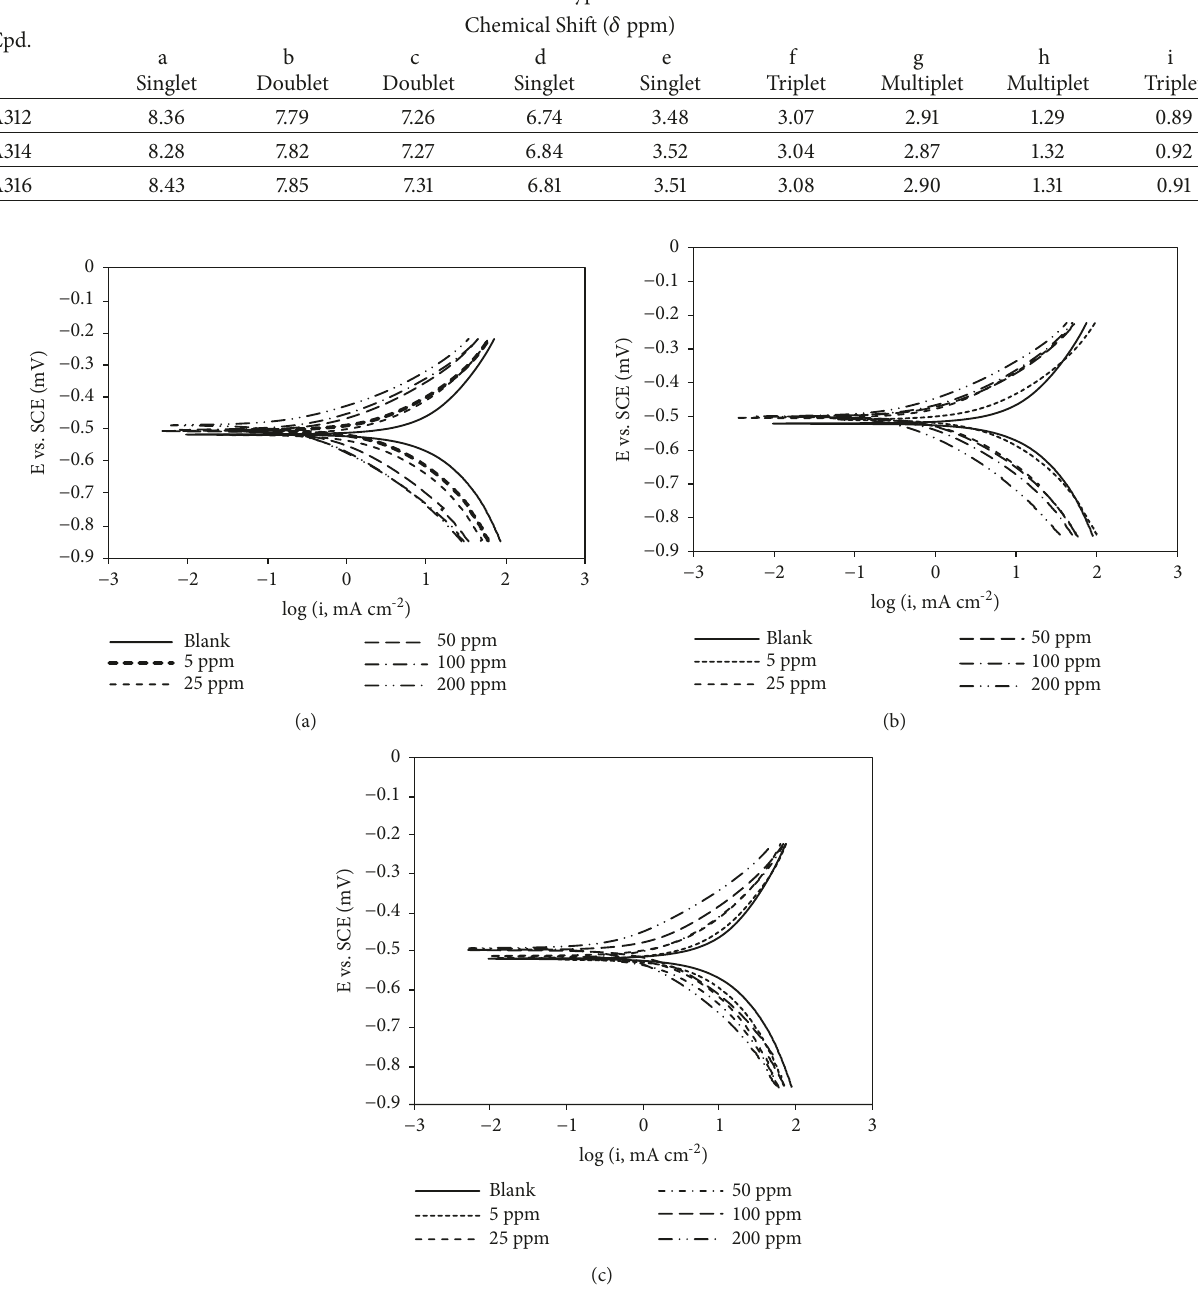
Figure 3: Potentiodynamic polarization of API X52 steel in 1M HCl with different concentrations of the synthesized corrosion inhibitors, (a) A312, (b) A314, and (c)